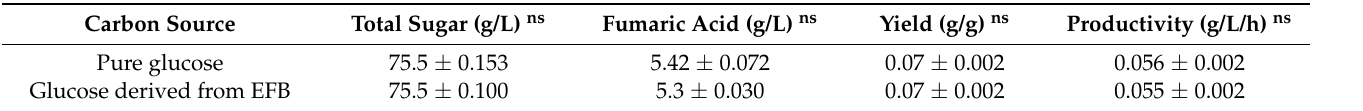
Table 1. Fumaric acid production from pure glucose and from glucose derived from steam-exploded oil palm EFB.